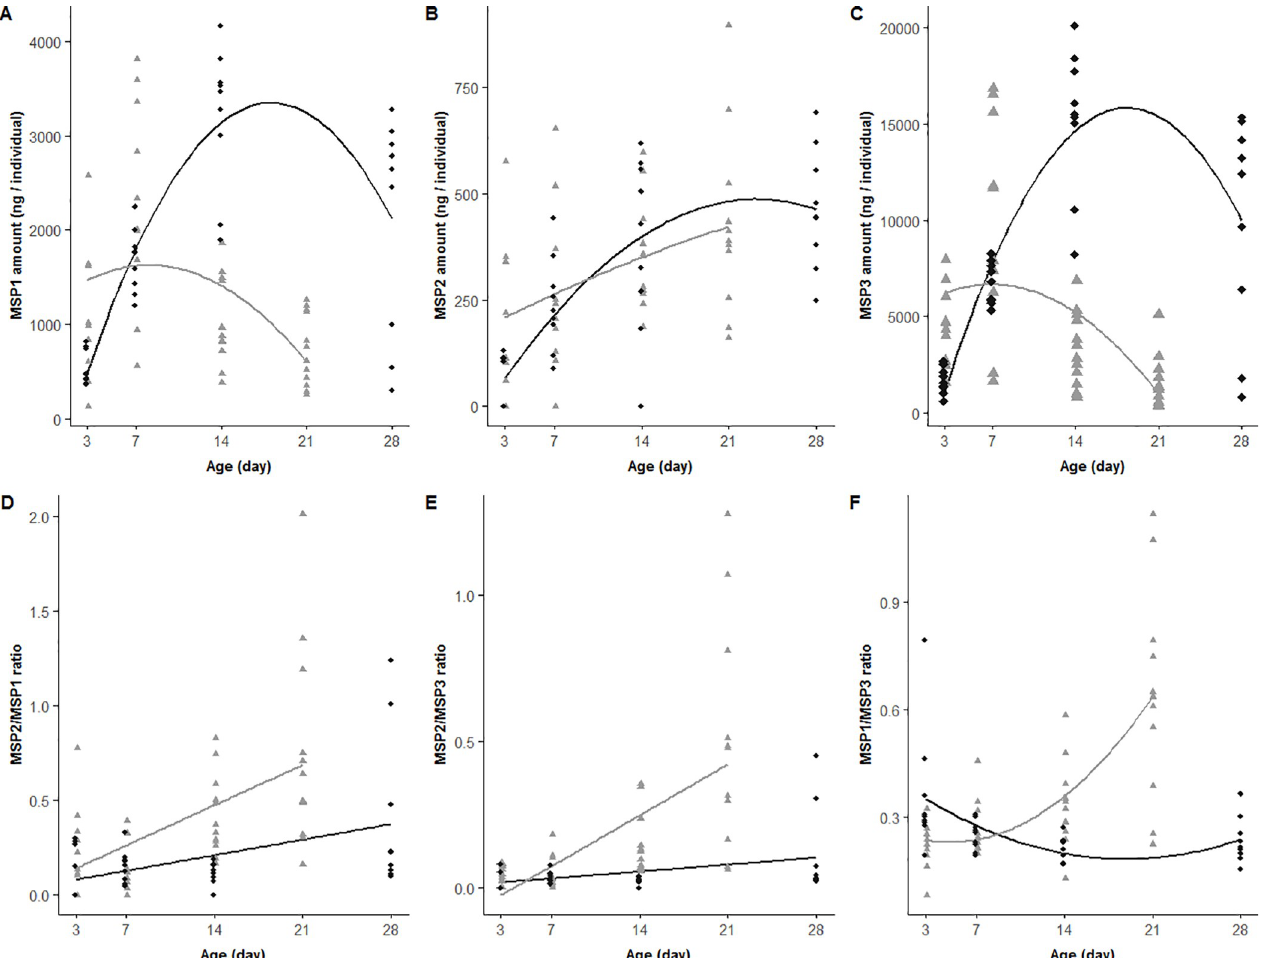
Fig 5. Variation in MSP composition as a function of the age of males reared at 20˚C (black diamonds) and at 27˚C (grey triangles) in experiment B. (A) MSP1, (B) MSP2 and (C) MSP3 amounts (ng/individual), (D) MSP2/MSP1, (E) MSP2/MSP3 and (F) MSP1/MSP3 ratios. Lines represent the model estimates that best fit the